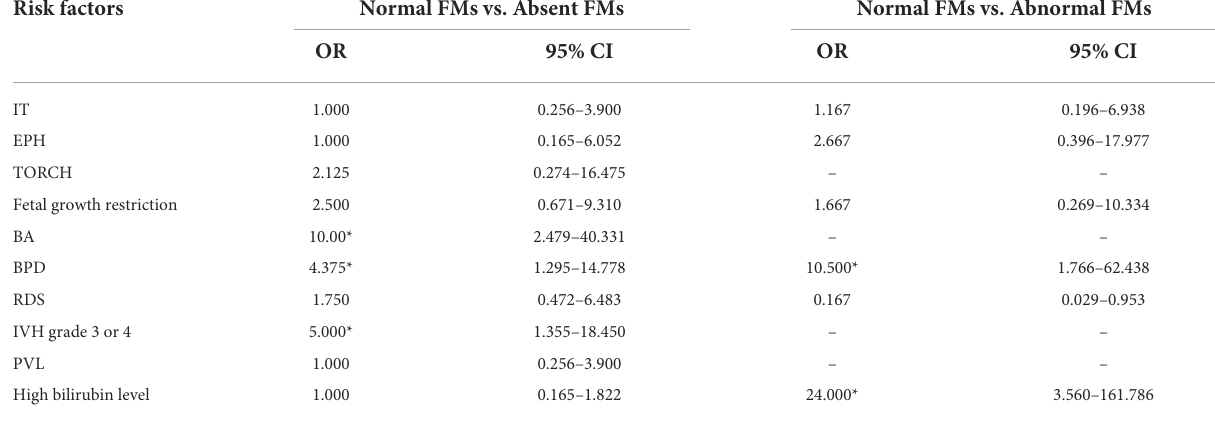
TABLE 6 Associations of risk factors with atypical GMs. Risk factors Normal FMs vs. Absent FMs Normal FMs vs. Abnormal FMs OR 95% CI